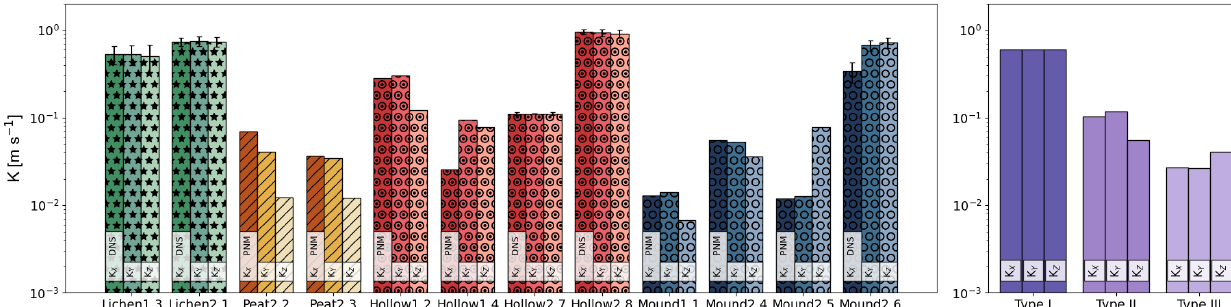
Figure 8. Diagonal components of the hydraulic conductivity tensor (ms − 1 ) on the x ( K xx ), y ( K yy ) and z axes ( K zz ) based on DNS on a representative elementary volume of hydraulic conductivity (REV K ) for Type-I samples and with a PNM for Type-II and Type-III